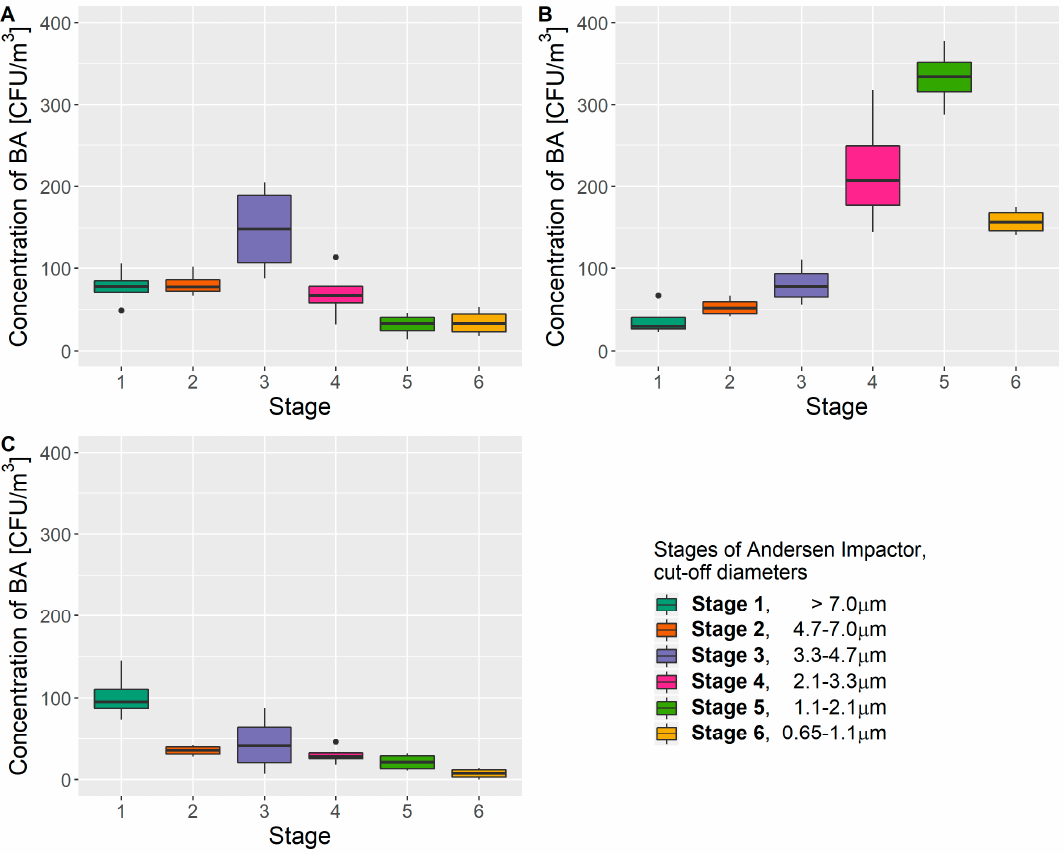
Figure 1. Average concentration of bacterial colony-forming units (CFU) per cubic meter collected from the different stages of the Andersen six-stage impactor (ANDI): ( A ) before gym classes (BGC), ( B ) during gym classes (DGC) and ( C ) in the outdoor air (OUT).